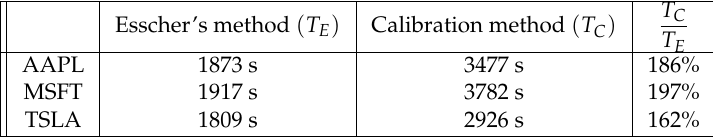
Figure 3. Computational times (in seconds) of both methods (with an Asus ZenBook